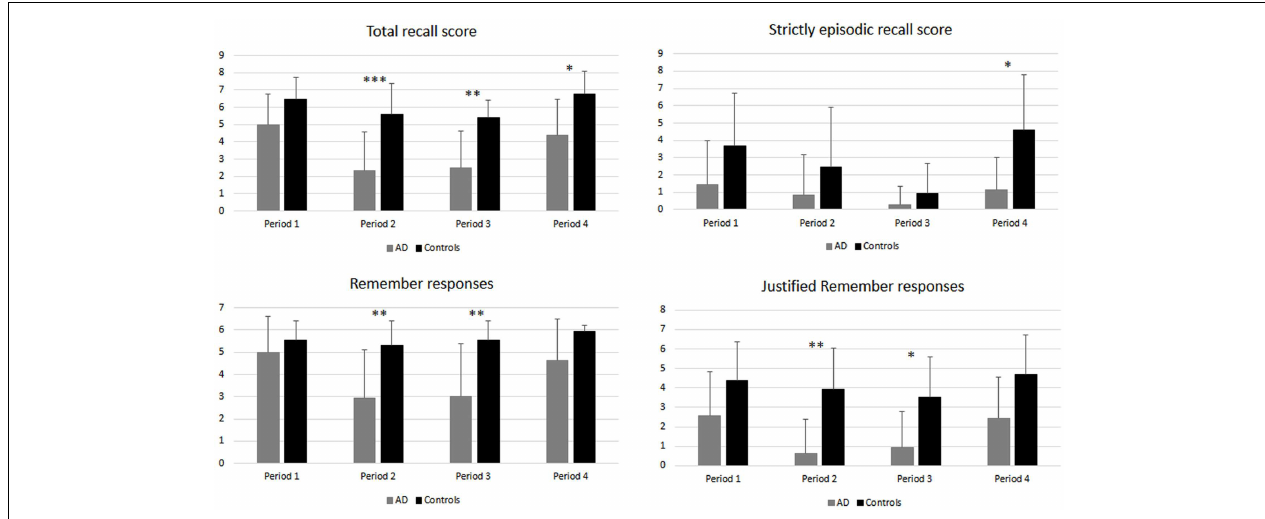
FIGURE 2 |Autobiographical memory scores inAD patients and healthy controls for the four time periods . Stars indicate between group differences. * p < 0.05; ** p < 0.01; *** p <